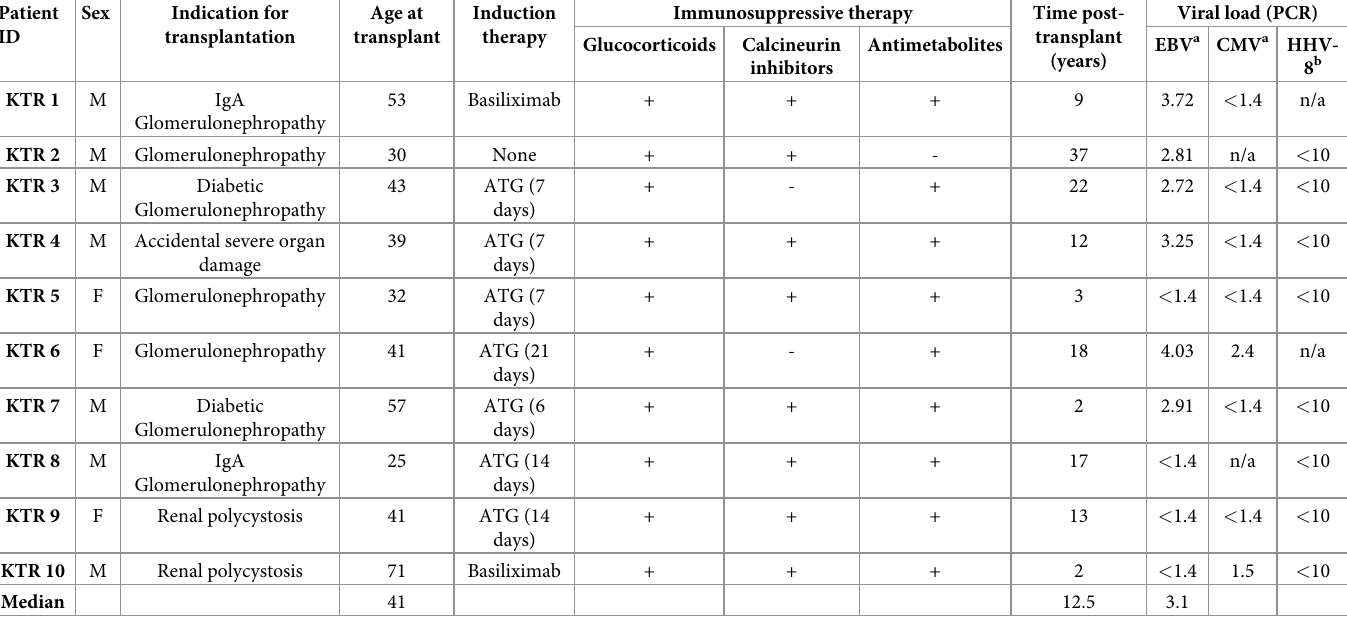
Table 4. Patients